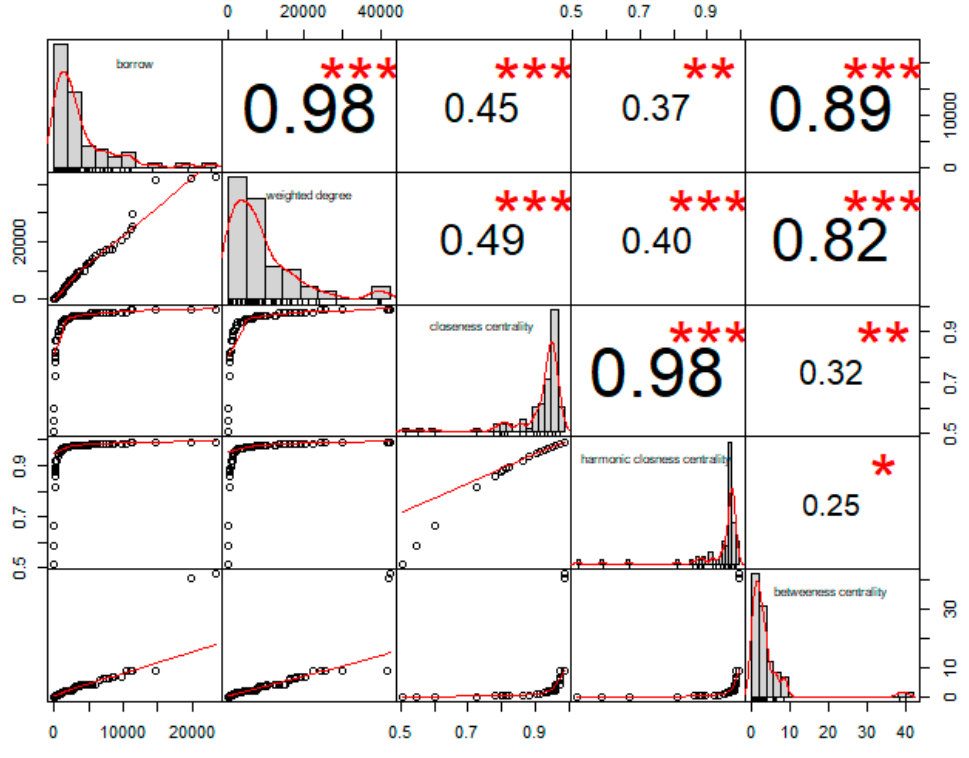
Figure 8. Pearson correlation coefficient matrix. Tips ： The size and number of * shapes illustrate the size of the correlation coefficient value between different indicators Table 6. Ranking results of indicators (top 10).